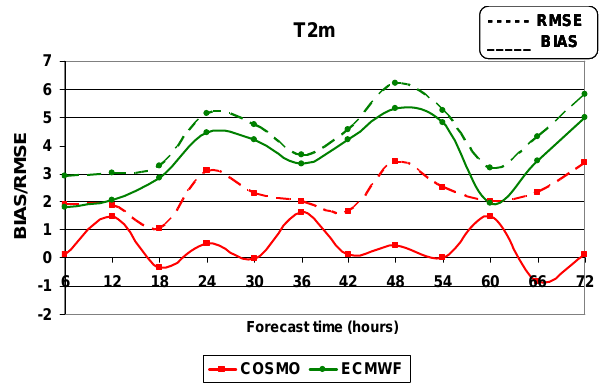
Fig. 6. Average BIAS and RMSE values for 2m temperature using data from 10 stations, using the 16 and 17 February 00:00UTC runs, for both COSMO and ECMWF deterministic models.